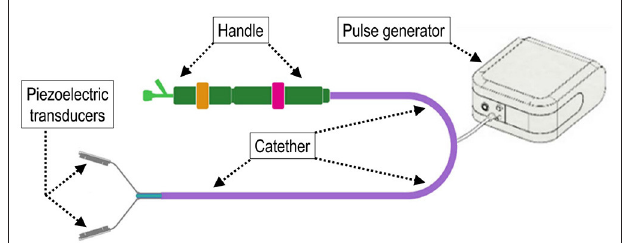
FIGURE 1 | Scheme illustrating the main components of the trans-catheter debridement device (TDD) in the configuration as it was employed for the in vivo trial. The device consists of two piezoelectric transducers that can be juxtaposed to deliver shockwaves on both sides of the region of treatment. The impulse-transducing cables are inserted into an intravascular catheter and operated by a handle at the other extremity to deploy and de-sheath the